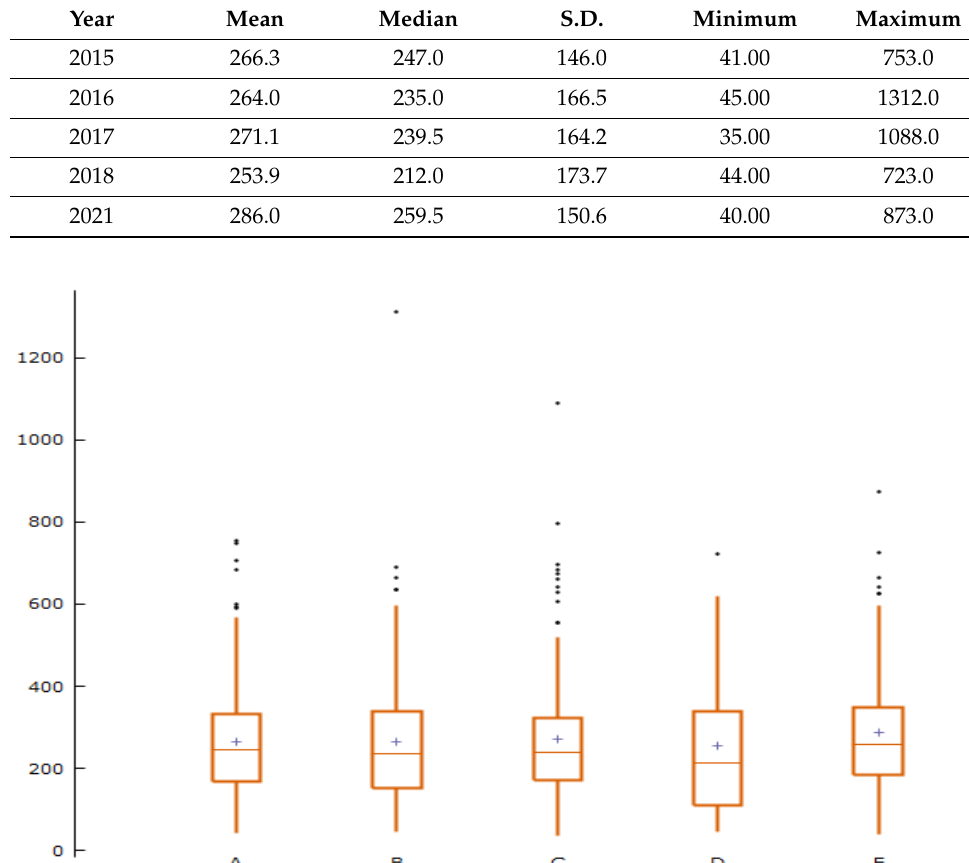
Figure 8. The box plot of mean visiting annual frequency (no. of people referring to Table 1) in TFE Masaryk Forest K ř tiny (forest road “ Č ervená”) in the subsequent years before and after the COVID- 19 pandemic (where A is 2015, B is 2016, C is 2017, D is 2018 and E is 2021). Table 1. Summary statistics of the frequency of visitors of TFE Masaryk Forest K ř tiny (Forest Road “ Č ervená”) in the subsequent years.